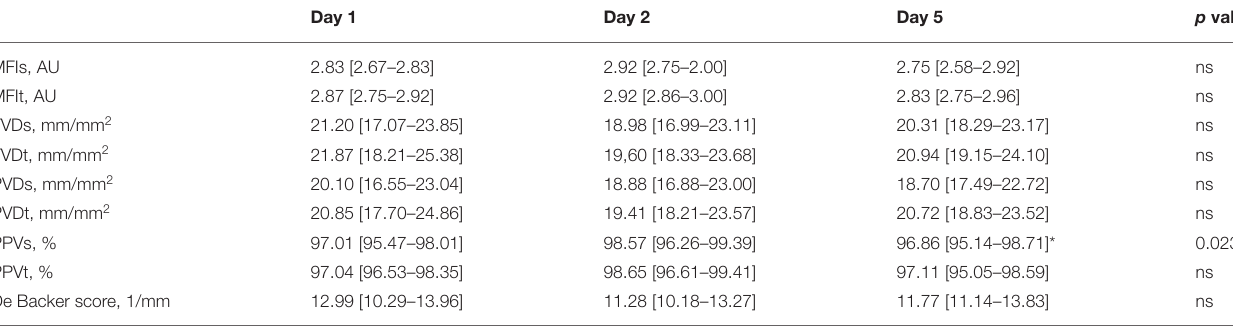
TABLE 3 | Descriptive of microvascular parameters at day 1, day 2, and day